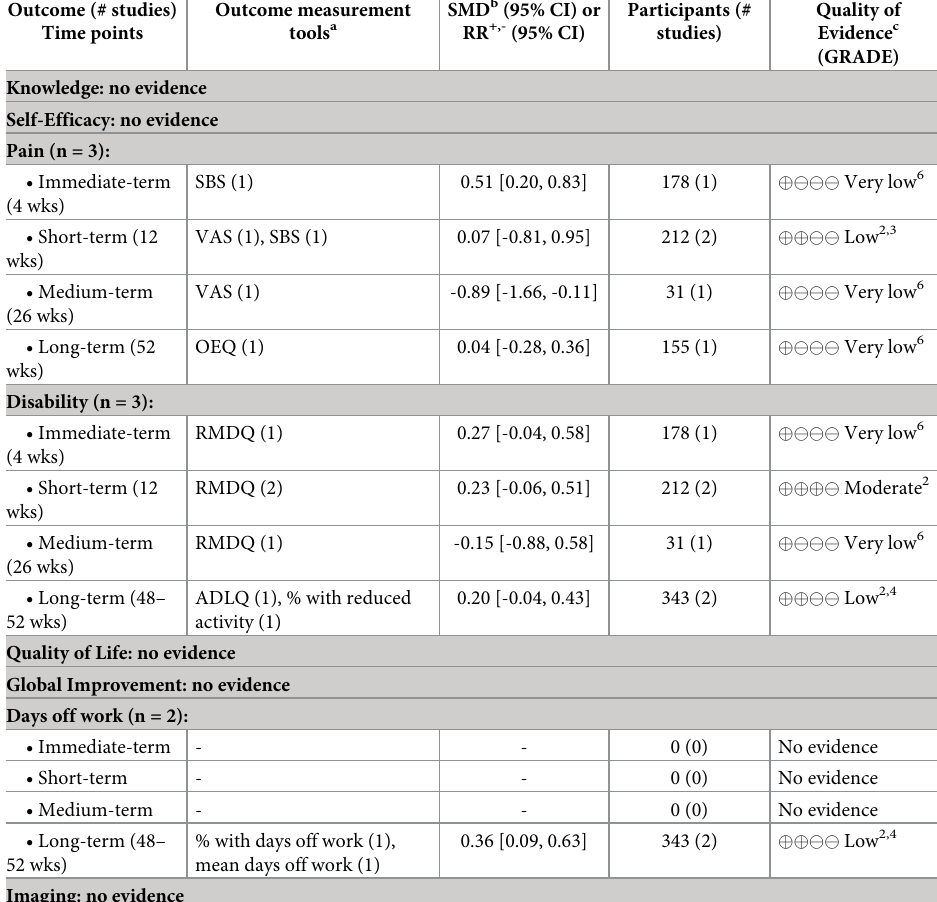
Table 5. Summary of findings: Education materials compared with another intervention for acute/subacute low back